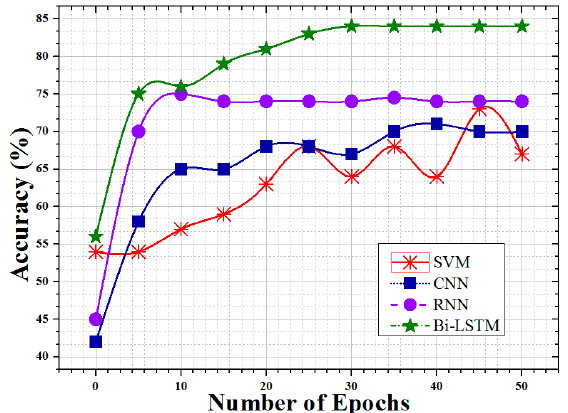
Figure 9. Classifier accuracy with different number of epochs.